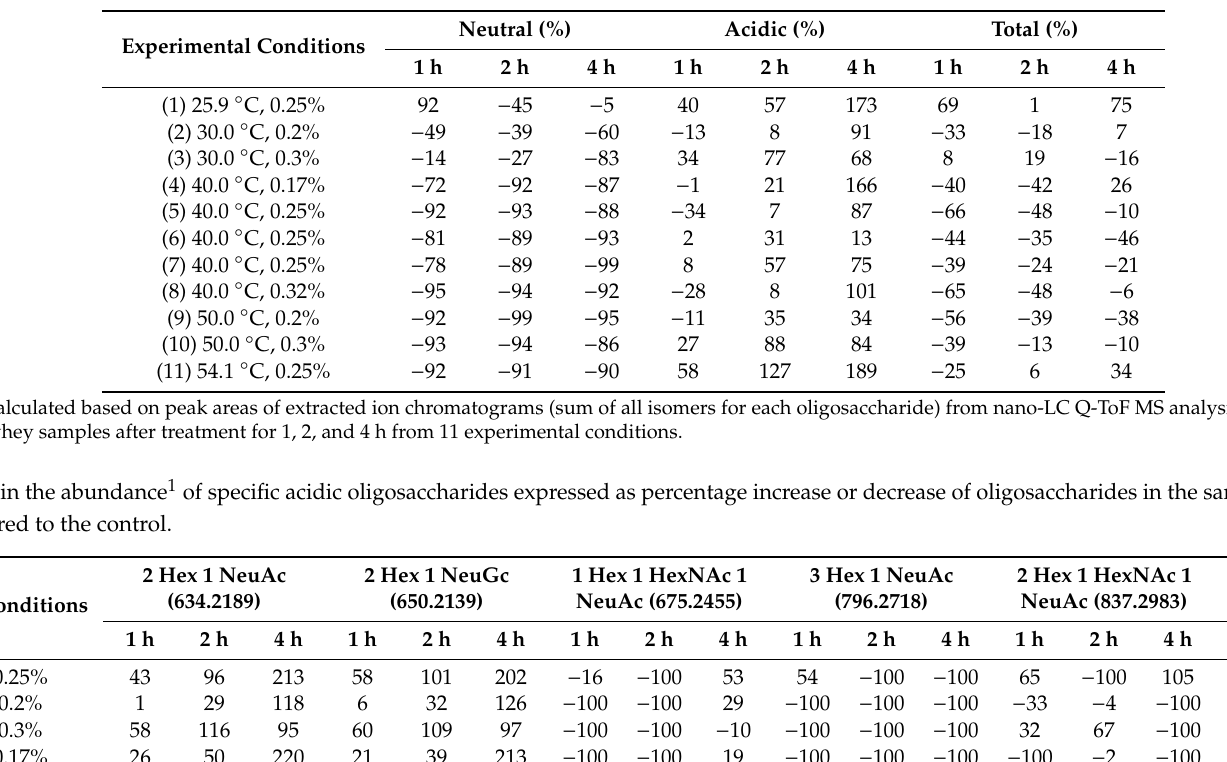
Table 1. Changes in the total abundance 1 of neutral and acidic oligosaccharides expressed as percentage (increase or decrease) of oligosaccharides in samples after treatments at 1, 2, 4 h compared to the control.